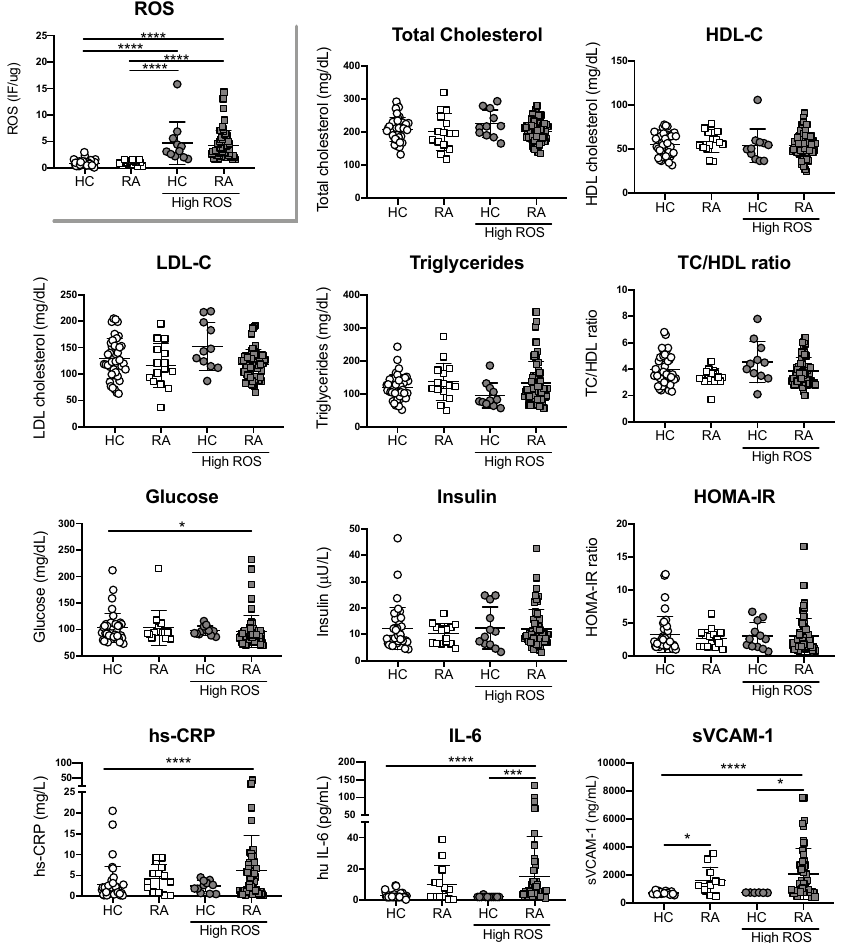
Figure 2. Increased ROS production is associated with inflammatory factors, but not traditional